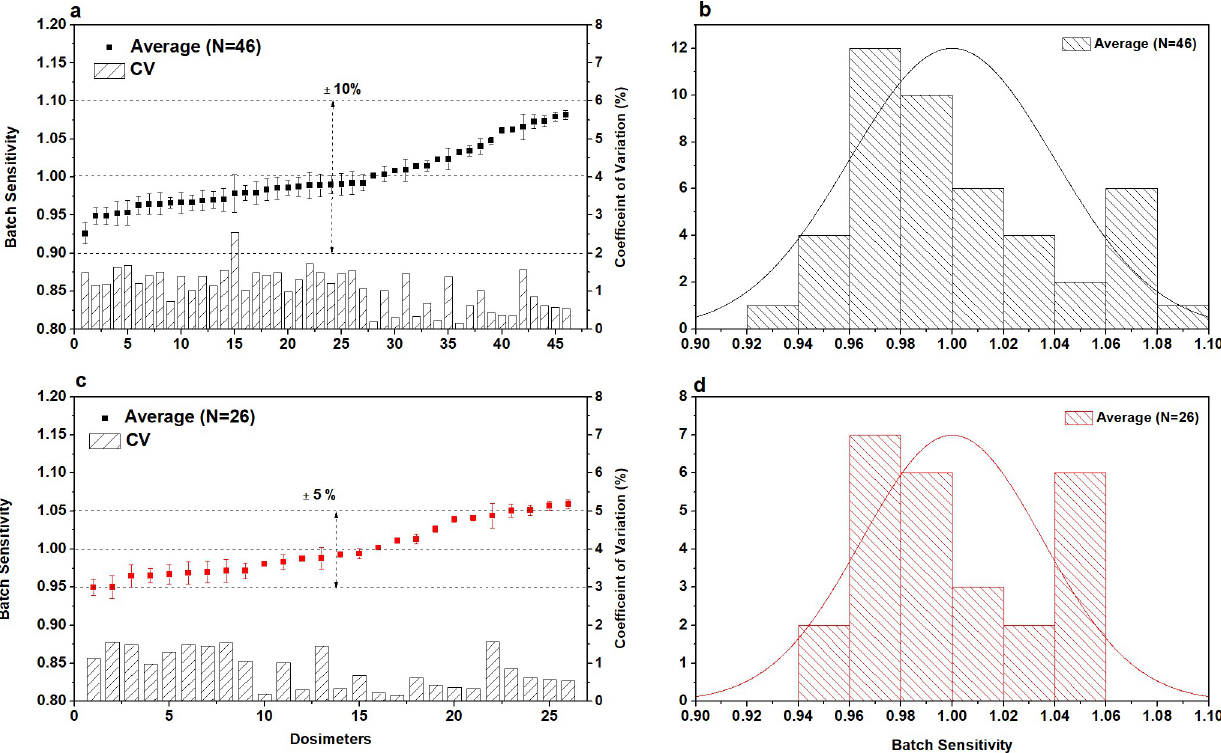
Fig 3. Comparison of batch sensitivity and coefficient of variation (CV) for reproducibility in this study. (a) Total OSLDs in one batch (N = 46); (b) Histogram of Total OSLDs (frequency); (c) Sampling OSLDs in one batch (N = 26); and (d) Histogram of Sampling OSLDs in one batch (frequency).